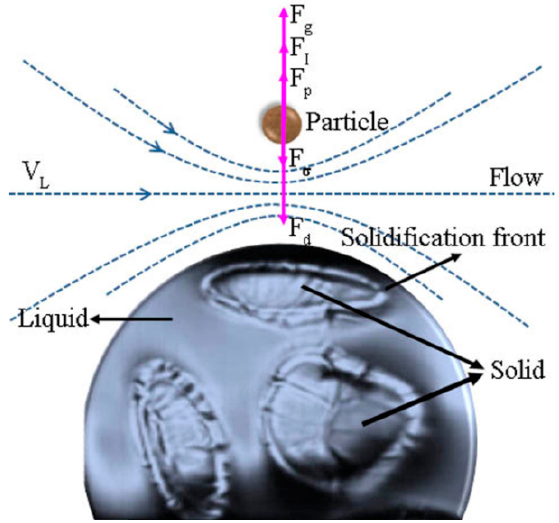
Figure 8. Schematic diagram of the forces acting on a particle in the vicinity of the solid–liquid in-